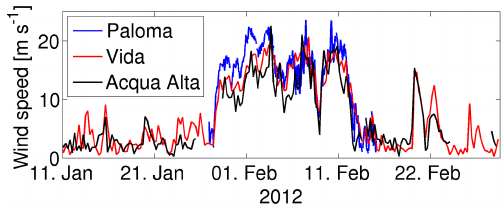
Figure 4. Hourly wind speeds measured at oceanographic platforms Vida, Paloma and Acqua Alta during January and February